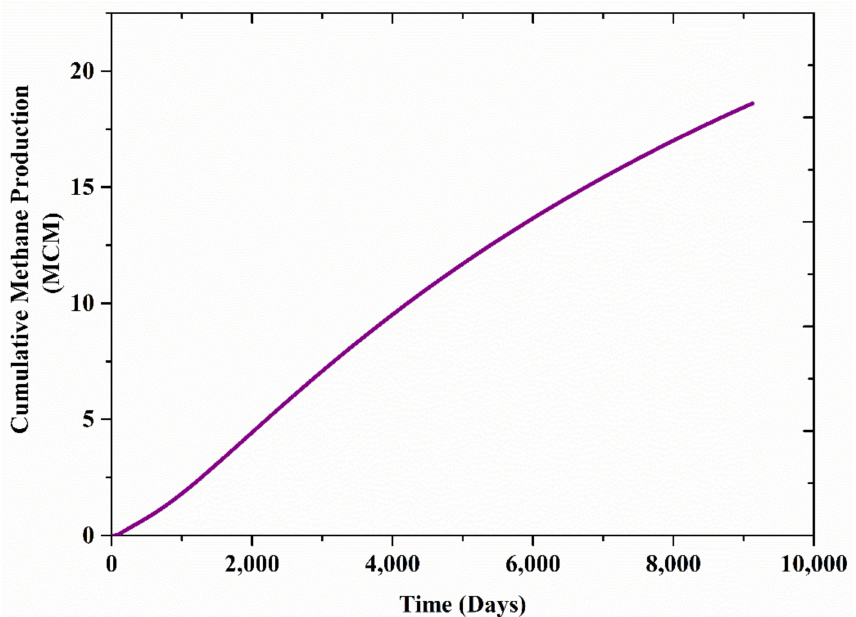
Figure 4. Cumulative methane production vs.